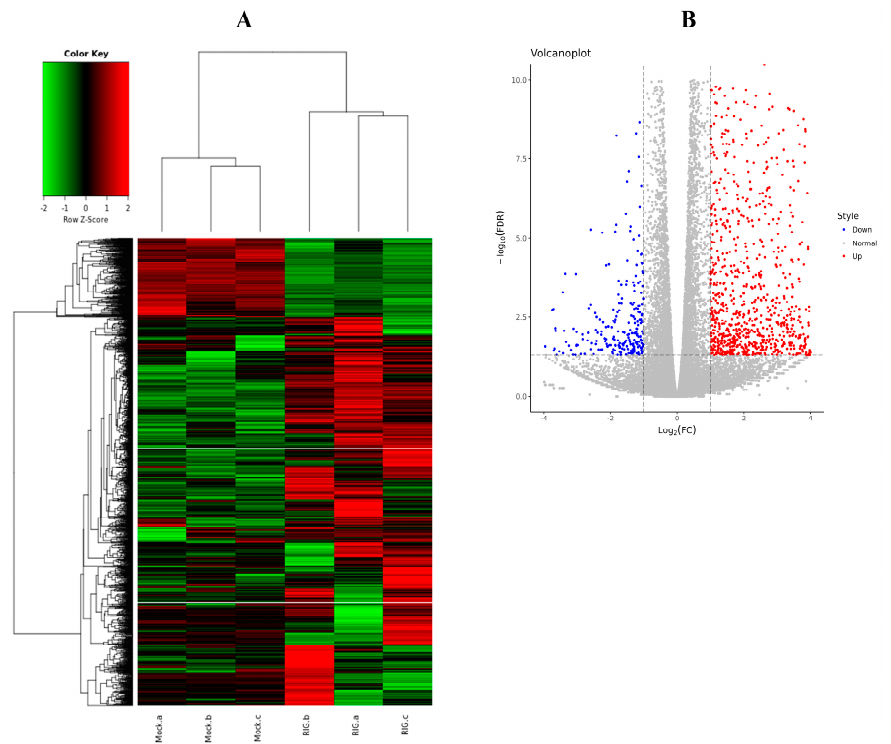
Figure 7. Differentially expressed genes (DEGs) analysis between Flag-RIG-I transfection group and mock transfection group. ( A ) Clustering analysis heatmap of DEGs. ( B ) Volcano plot visualization of DEGs.